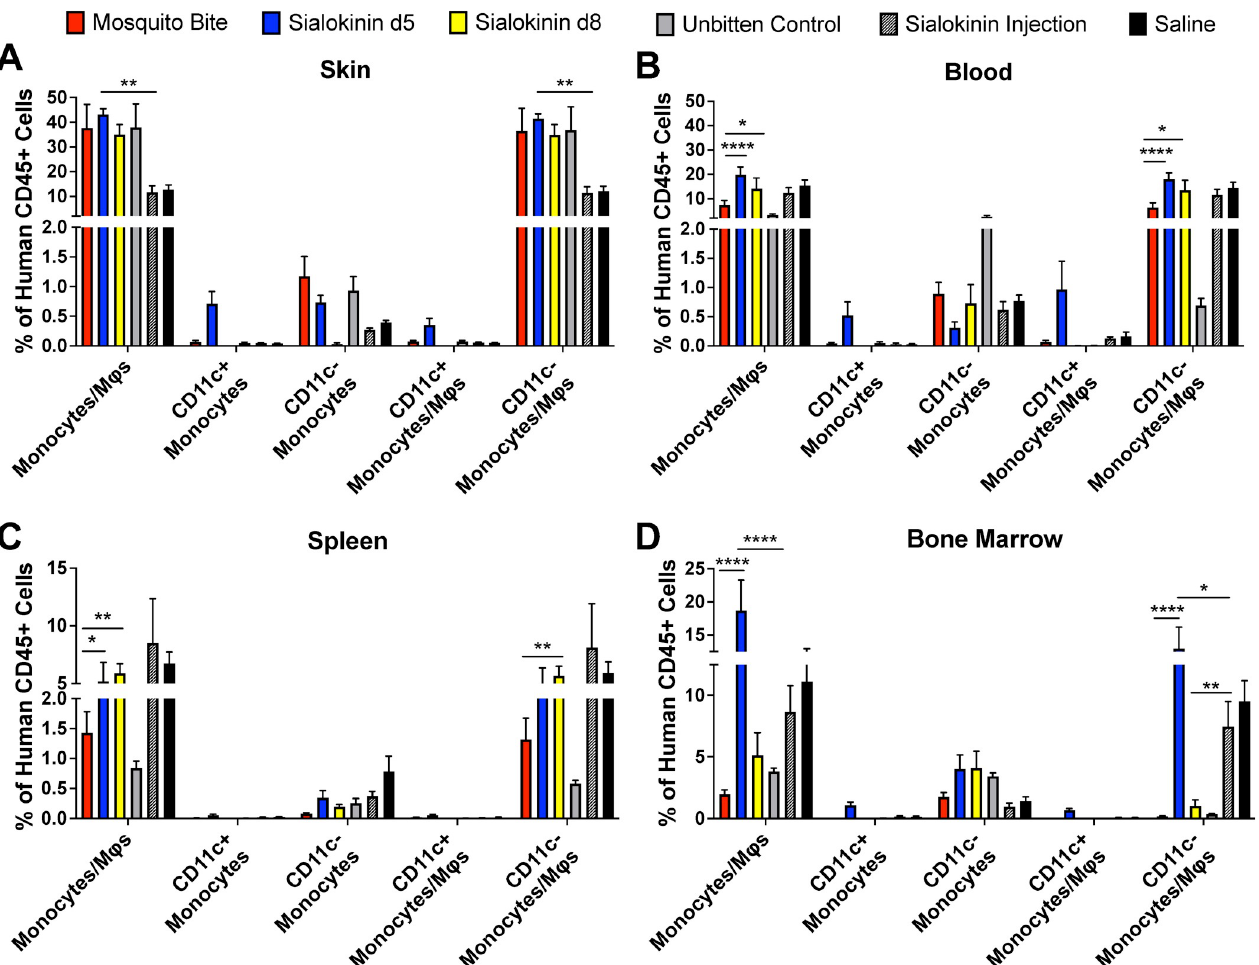
Fig 1. macrophage populations in humanized mice/macrophage populations in humanized mice. Hu-NSG mice were subjected to four bites each from sialokinin knockout mosquitoes and were euthanized 7 days postbite. Skin ( A ), blood ( B ), spleen ( C ), and bone marrow ( D ) were collected and changes in monocyte/macrophage populations were assessed via flow cytometry. Mosquito Bite indicates mice bitten by wild-type mosquitoes, and Unbitten indicates mice that were not bitten by mosquitoes. Data are represented as the mean percentage of the cell population out of total human CD45+ cells. Error bars represent 1 standard error of the mean (SEM). Statistical significance was determined using two-way ANOVA followed by multiple comparison t-tests using the Holm-Sidak correction. The threshold for significance was p < 0.05. Asterisks indicate: � = p < 0.05; �� = p < 0.01; ���� = p < 0.001. Cell markers used to describe populations: Monocytes/M ϕ s: CD45+, CD3-, CD14+; CD11c+ Monocytes: CD45+, CD3-, CD11c+, CD11b+; CD11c- Monocytes: CD45+, CD3-, CD11c-, CD11b+; CD11c+ Monocytes/M ϕ s: CD45+, CD3-, CD14+, CD11c+; CD11c- Monocytes/M ϕ s: CD45+, CD3-, CD14+, CD11c-. Abbreviations: M ϕ ,